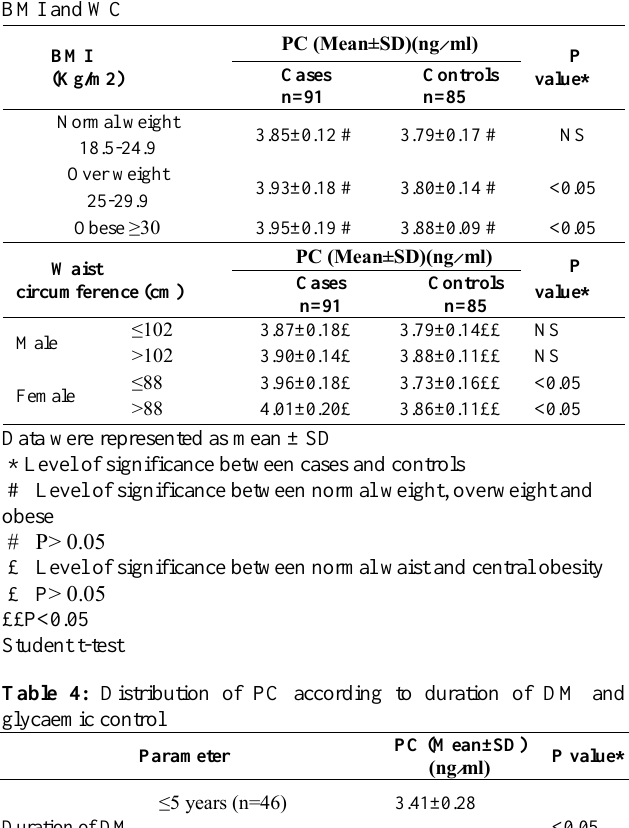
Table 3: Distribution of PC of the study population according to